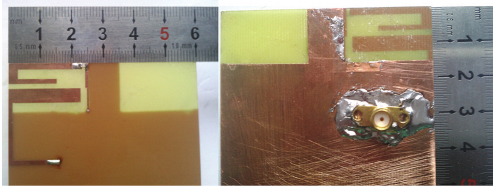
Figure 2: The photos of the proposed